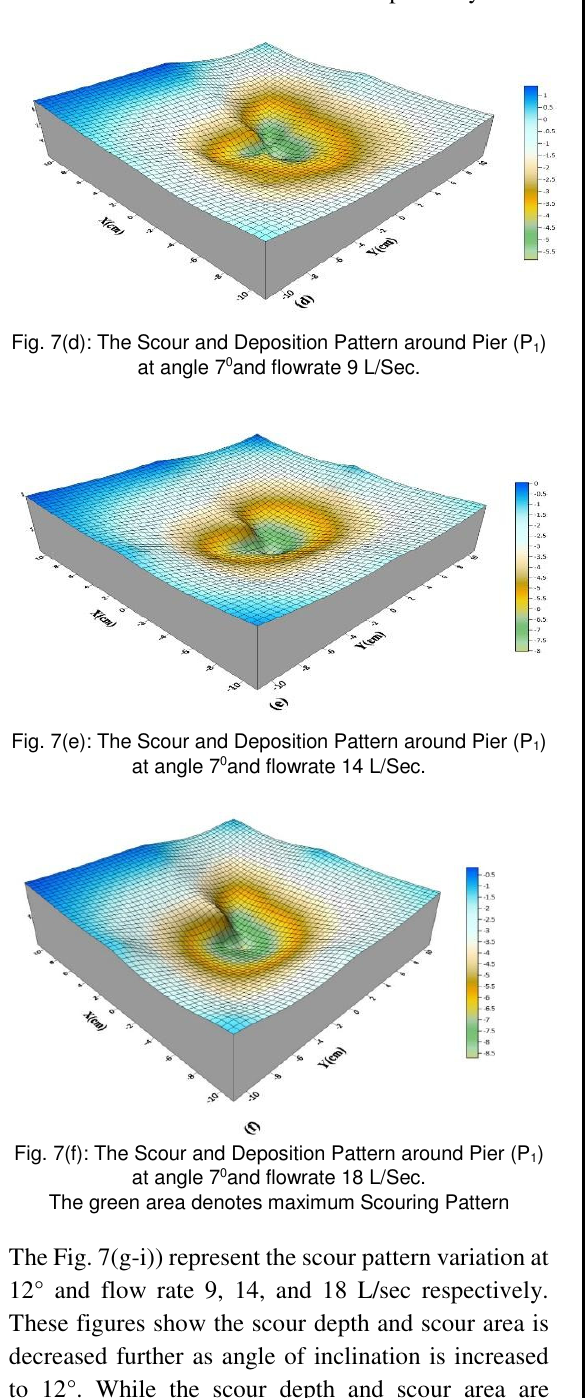
Fig. 7(j): The Scour and Deposition Pattern around Pier (P 1 ) at angle 15 0 and flowrate 9